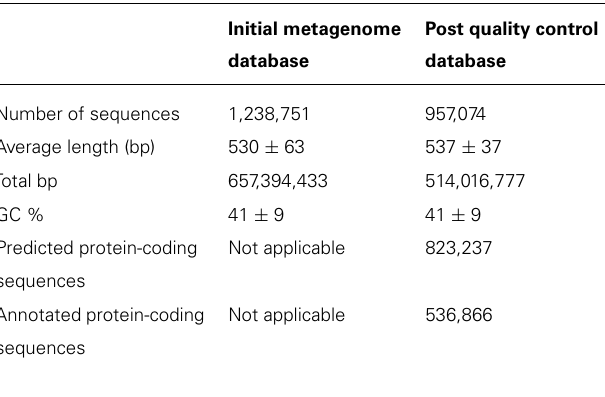
Table 2 | Data on the number and quality of sequences in the